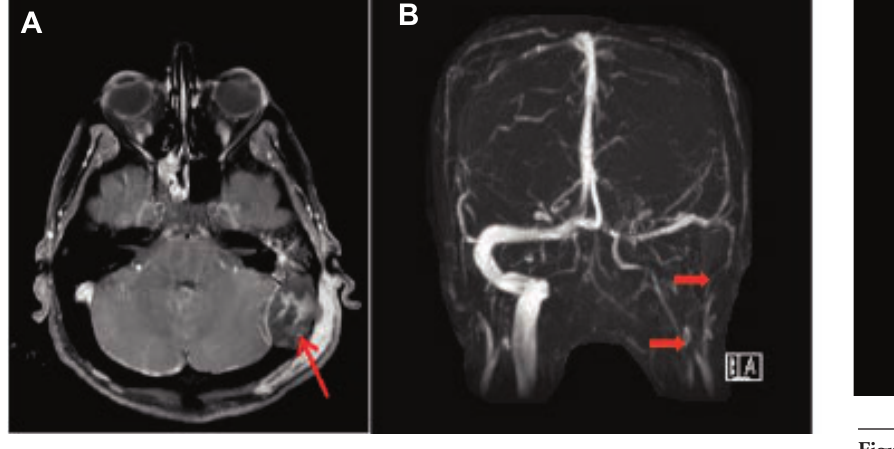
Figure 1. Patient MRA obtained on HD1 of first admission. A) T1-weighted precontrast imaging demonstrating a 3×4 cm area of high signal intensity extending posteriorly from the left mastoid, consistent with mastoid abscess versus osteomyelitis. B) MRV demon- strating sigmoid sinus and jugular thrombosis.